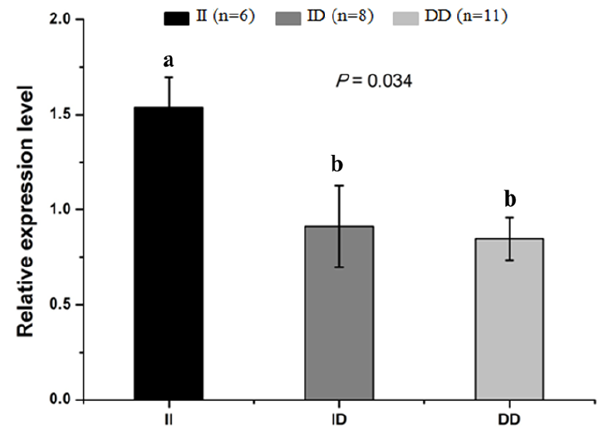
Figure 3. Comparison of SMAD3 gene expression levels among different genotypes in the 17 bp indel in QC fetal cattle. The ex- pression level was calculated with a 2 ( − (cid:49)(cid:49) Ct) value and normalized to the GAPDH gene. Error bars represented standard deviations of three different biological replicates; “a” and “b” denote values that differ significantly at P< 0 .